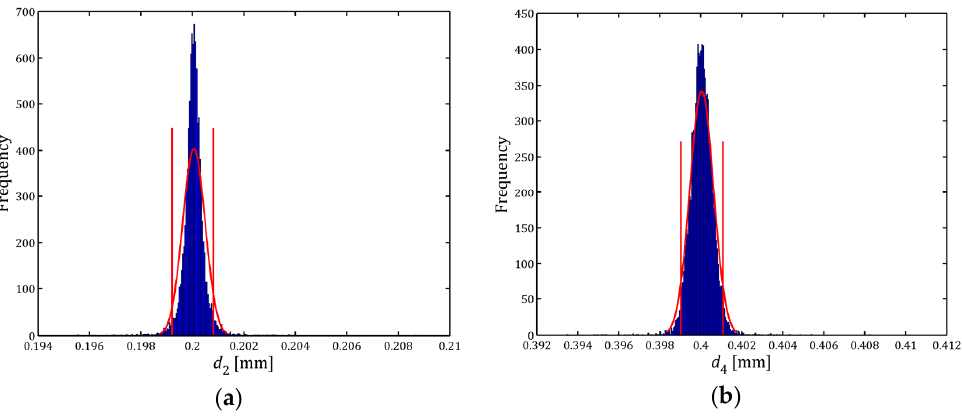
Figure 4. Hypothesis 2. ( a ) d 2 histogram; ( b ) d 4 histogram.